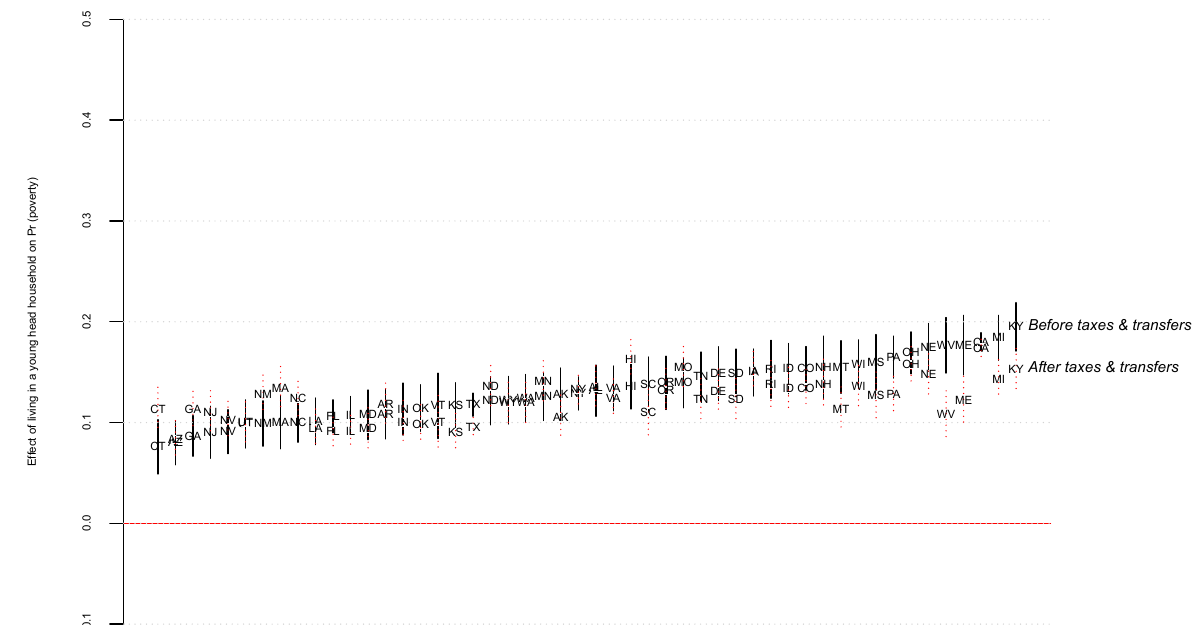
Figure 7: Young head of household penalty: effects of living with a head below age 25 on Pr (poverty) before and after taxes and transfers (2012–2016 CPS). Adjustments for SNAP, SSI, and TANF underreporting were made using the Urban Institute Transfer Income Model (TRIM). Effects represent coefficients from varying slope linear probability models predicting SPM poverty. The nonvarying slopes in the model are year fixed effects and a control for metropolitan and/or nonmetropolitan status. States are indicated by their postal code